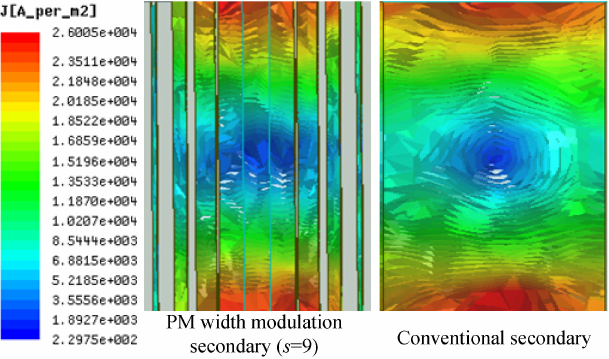
Figure 4. PM eddy currents of the PM width-modulation array ( s = 9) and a conventional